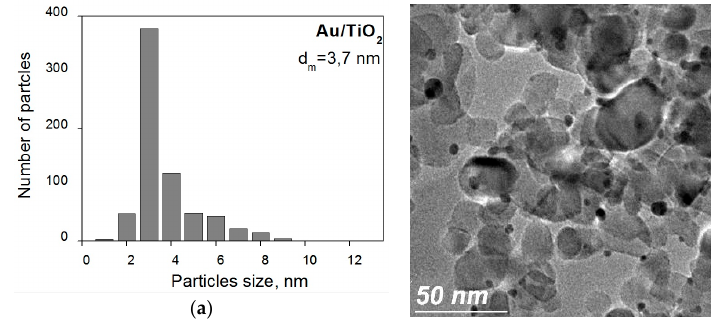
Figure 1 . Cont . Figure 1. Cont